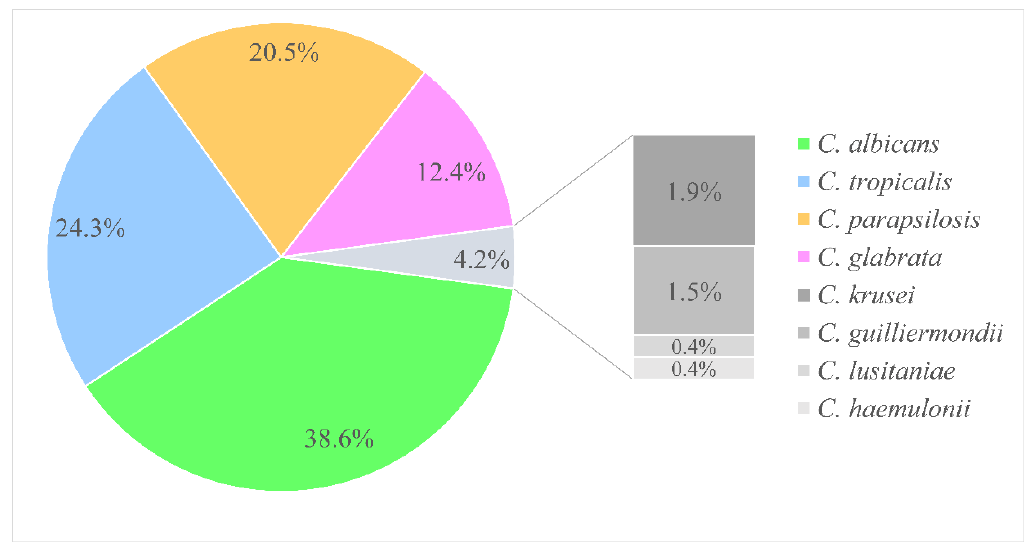
Figure 2. Distribution of Candida species in candidemia from 2016 to 2020 ( n = 259).